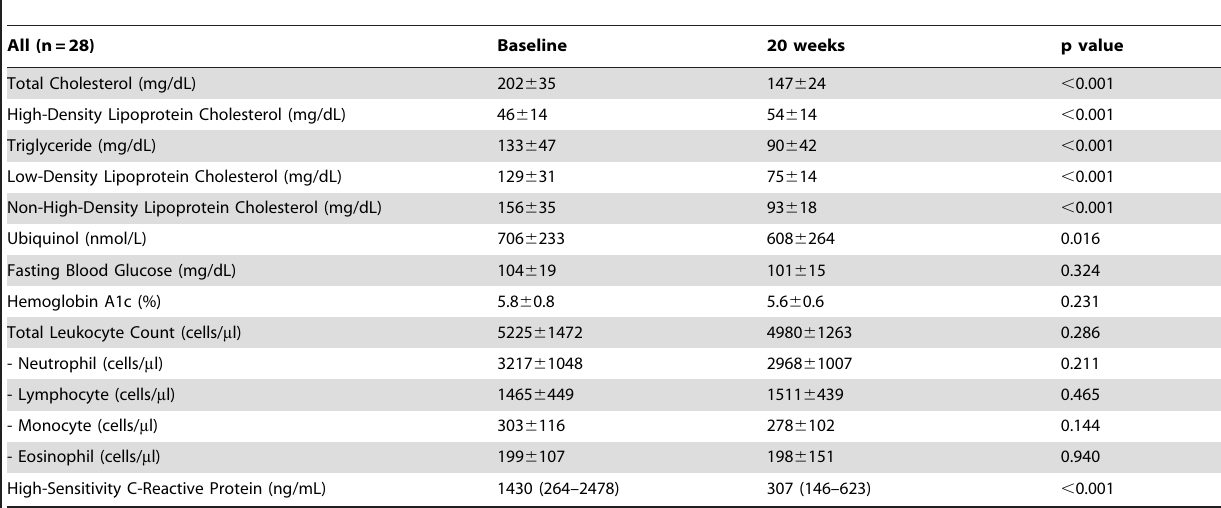
Table 2. Effects of Statin-Exercise Treatment on Various